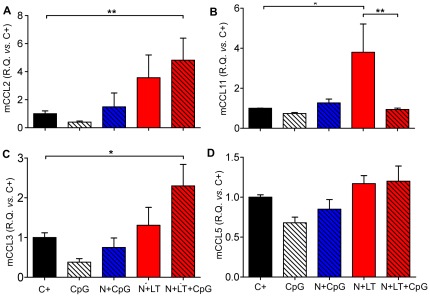
CpG added to the neonatal vaccine decreased pulmonary CCL11 mRNA expression upon RSV challenge.The level of expression of genes encoding mCCL2 (A), mCCL3 (C), mCCL5 (D) and mCCL11 (B) was monitored by quantitative real time PCR of RNAs extracted from individual lungs collected at d5 p.i. Data were normalized to the mHPRT and expressed relative to the unvaccinated infected control group (C+) (R.Q. = 100×2−ΔΔCt). Data are mean±SEM from n≥4 mice per group (Mann Whitney test, * p<0.05). Two independent experiments were done.